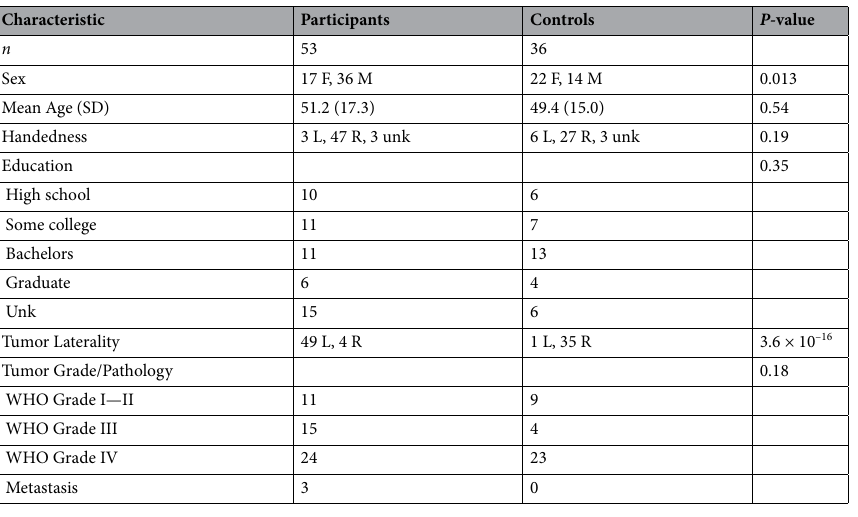
Table 1. Demographics and clinical summary. Comparisons between categorical variables were made with the chi-squared test while continuous variables were compared with the Wilcoxon rank-sum test for participants with dominant hemisphere lesions and controls with non-dominant hemisphere lesions. Handedness was determined using preoperative magnetoencephalography. Education was self-reported in patients who completed the Neuro-QoL assessment. Pathologic diagnoses were made by board-certified pathologists using the World Health Organization (WHO) Revised Classification of Tumors in the CNS.